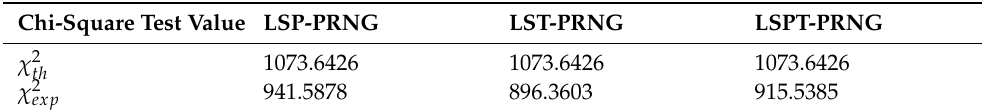
Table 4. Chi-Square test.